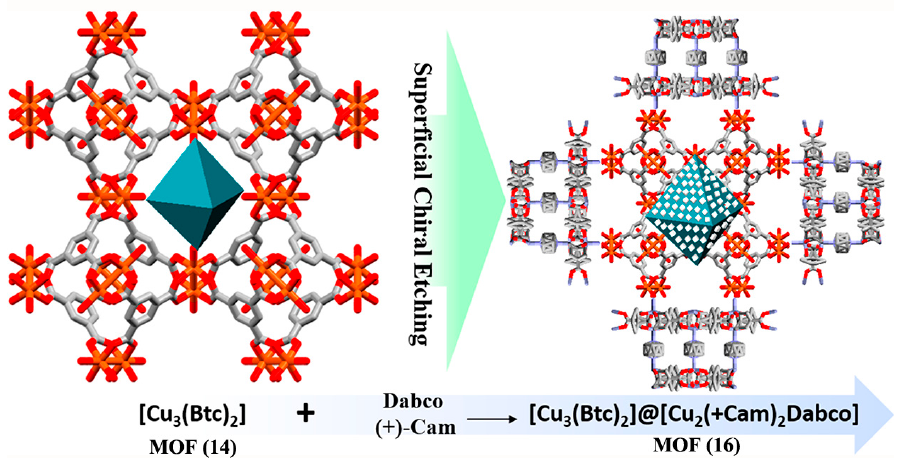
Figure 8. Schematic representation of the superficial chiral etching process for MOF 16 . Reproduced from [72] with permission from the American Chemical Society.